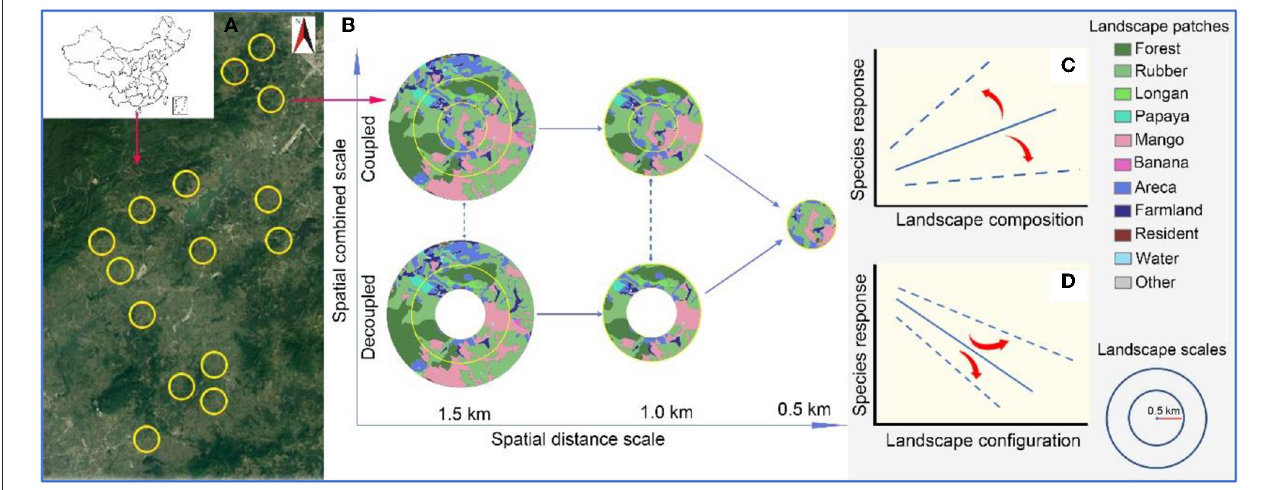
FIGURE1 Schematic diagram of the study area and landscape settings. The yellow circles (1.5km radius) in the left panel (A) indicate the spatial distribution of the 15 landscapes. The right panel (B) shows the processing of the landscape at spatial distance and combined scale. Distance scales refer to buffer rings with 0.5, 1, and 1.5km radius around the central mango patch, respectively [x-coordinate, (B) ], and the combined scale refers to whether to remove the ring with 0.5km [y-coordinate, (B) ]. (C, D) Indicate the potential impact of spatial scale on landscape heterogeneity-species relationships.